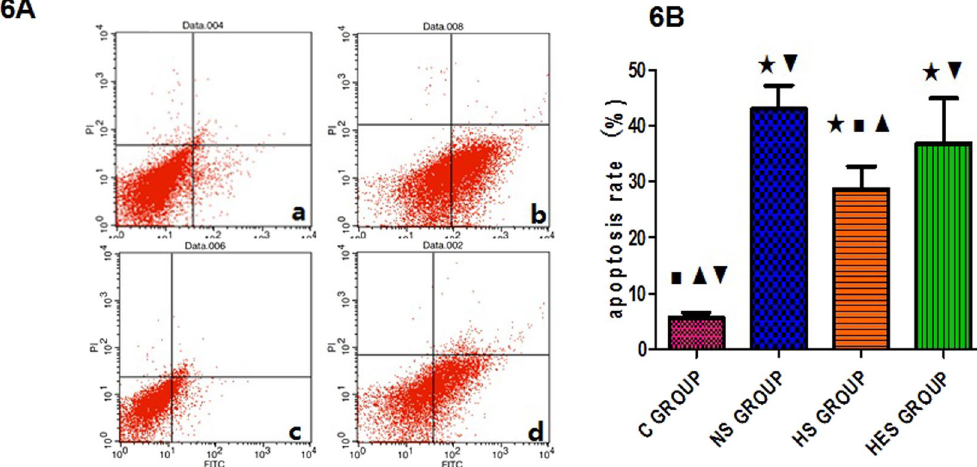
Figure 6. Hippocampal CA1 neuronal apoptosis cellS by Flow cytometry assay. ( A ) Hippocampal CA1 neuronal apoptosis cells by Flow cytometry assay in NS, HS, HES and control (C) groups. Lower left quadrant means normal cell, upper left quadrant means necrotic cell, lower right quadrant means early apoptotic cell and upper right quadrant means late apoptotic cell. Apoptosis cells include both early and late apoptotic cels. ( B ) Quantitative analysis results of neuronal cell apoptosis rate. ★ P < 0.05 vs control group; ◼ P < 0.05 vs NS group; ▾ P < 0.05 vs HS group; ▴ P < 0.05 vs HES